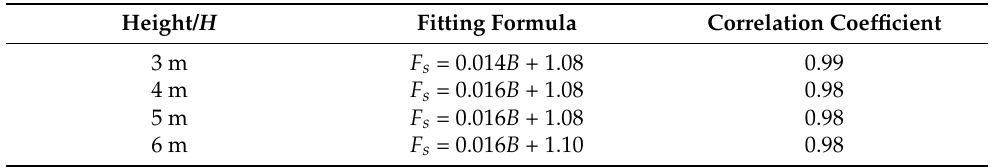
Table 2. Fitting formula between the stability factor and ELB width.